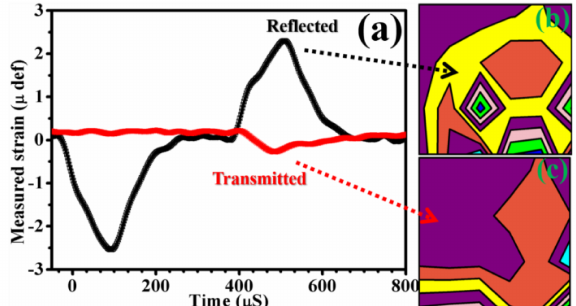
Figure 5. ( a ) Recorded shock wave signals by strain gauge sensors for the incident, reflected, and transmitted impact within the GLNRs, ( b , c ) short-term Fourier transform (STFT) signal processing of collected signals and corresponding strain contours showing the dispersion of shock energy, respectively, for reflected and transmitted